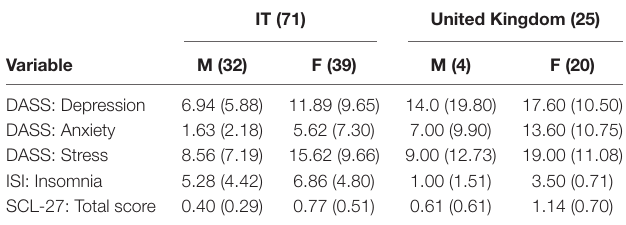
TABLE 3 | PCA loadings for “going outside” habits.